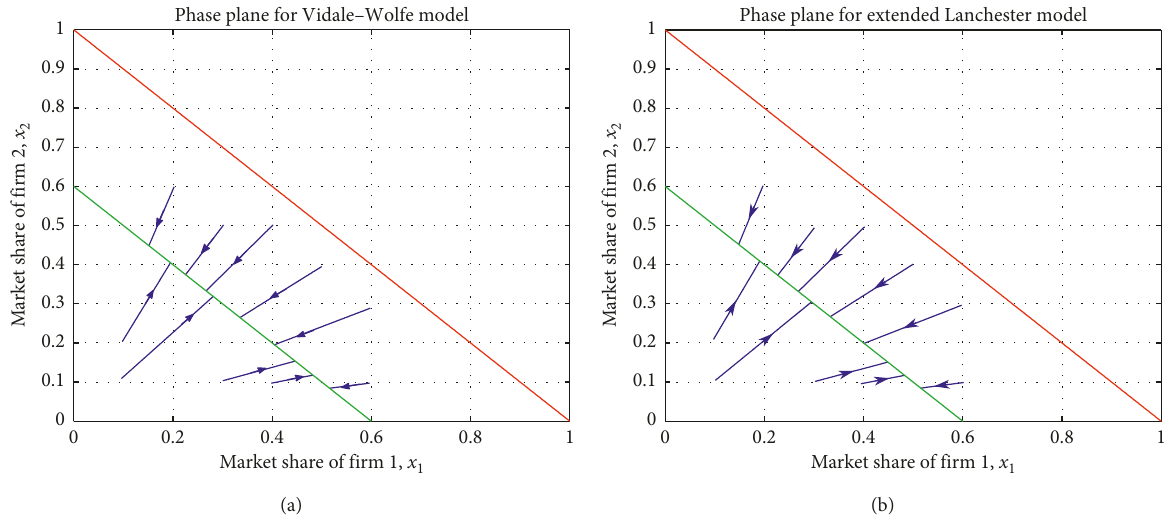
Figure 6: Phase plane of the market shares of firms x � 0 . 5 for firm 2 for (a) Vidale–Wolfe model expressed in equation (20) and (b) extended Lanchester model expressed in firm 1 and k 2 equation